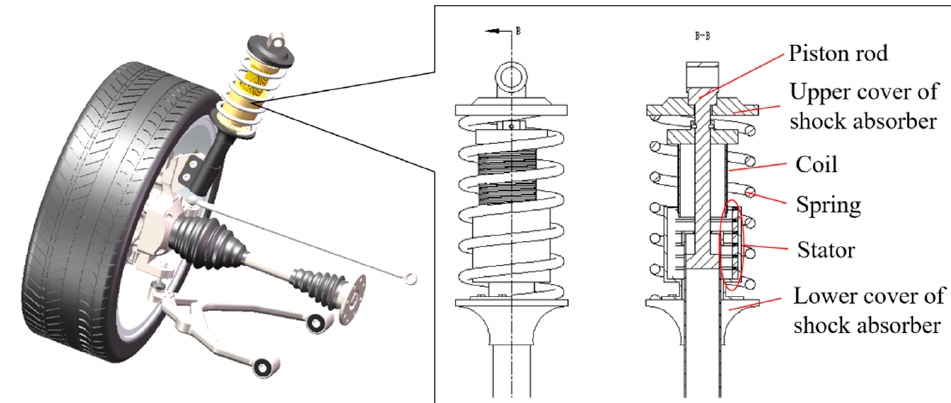
Figure 1. Structure of the dual-mode magnetic suspension.